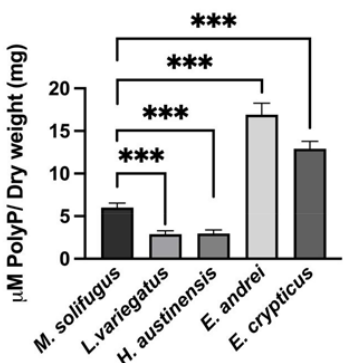
Figure 2. Annelida show different levels of mitochondrial polyP under basal conditions. The levels of polyP within mitochondria were measured under control conditions. Our results show that all the mesophilic counterparts had different levels of polyP within mitochondria. In fact, ice worms had intermediate concentrations of polyP, when compared with the other Annelida that were studied. Data are expressed as mean ± SEM of, at least, three independent experiments, conducted using biological triplicates. Values of p ≤ 0.05 were considered significant (*** p ≤ 0.001).